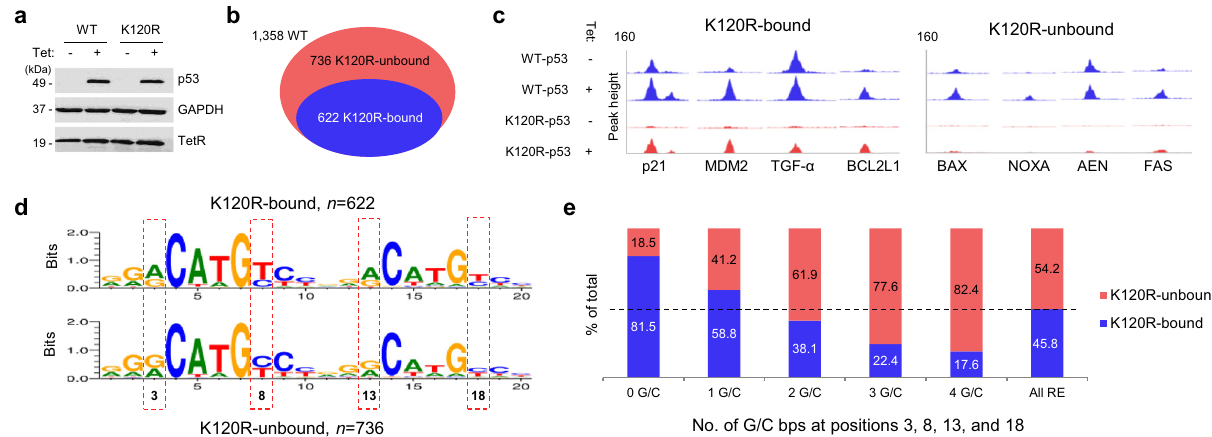
Fig. 1 Differential recognition by p53 of distinct classes of REs is encoded in the G/C vs. A/T bp content at positions 3, 8, 13, and 18 in the RE sequence. a Representative western blot from three independent experiments showing the expression of WT and K120R-p53 in Tet-inducible H1299 cells. b Venn diagram depicting the number of signi fi cantly enriched (with at least 0.3 counts per million [cpm] reads) and previously identi fi ed 10 WT p53 peaks, which are either bound (blue) or unbound (salmon) by K120R-p53 variant. c UCSC Genome Browser view of WT and K120R-p53 occupancy at selected K120R-bound and K120R-unbound-binding sites. Untreated ( − ) and Tet-treated ( + ) tracks for WT and K120R-p53 are shown in blue and salmon, respectively. d Motif analysis of K120R-bound (upper) and K120R-unbound (lower)-binding sites. Red dashed boxes highlight the differences at positions 3, 8, 13, and 18. e Percentage of either K120R-bound (blue) or K120R-unbound (salmon) REs with 0 ( n = 178), 1 ( n = 374), 2 ( n = 501), 3 ( n = 254), or 4 ( n = 51) G/C bps at positions 3, 8, 13, and 18. The dashed line presents the percentage among all WT p53-binding sites ( n = 1358), highlighting an increase in K120R sensitivity with an increase in G/C bp content. Tet tetracycline. TetR tetracycline repressor. Source data are provided as a Source Data fi